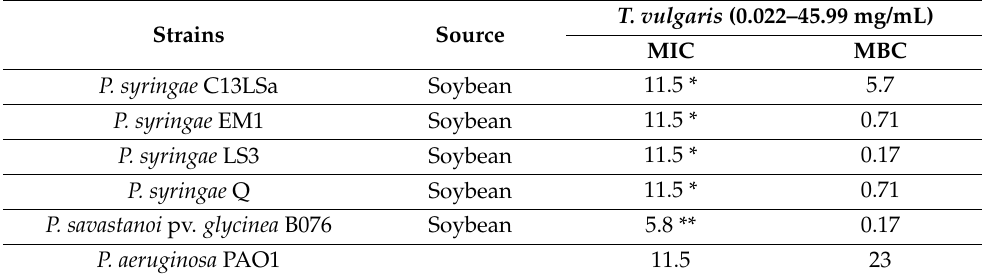
T. vulgaris (0.022–45.99 mg/mL) MIC MBC